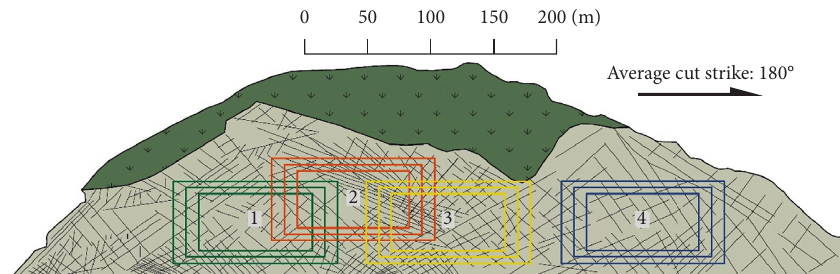
Figure 8: Sizes and locations of rectangular windows used to estimate mean trace length